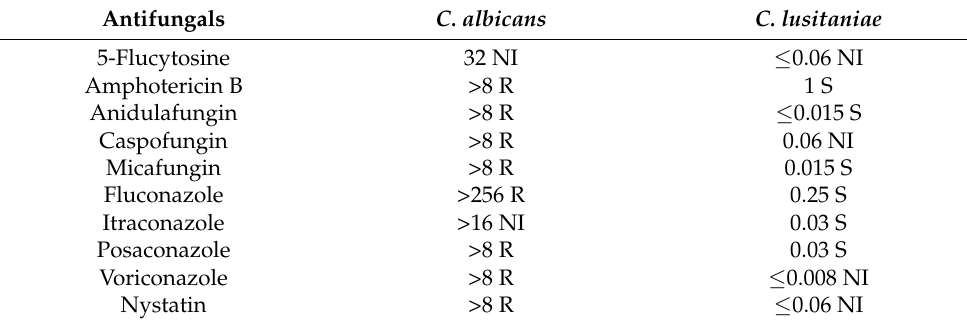
Table 1. Antimycogram performed after fungal